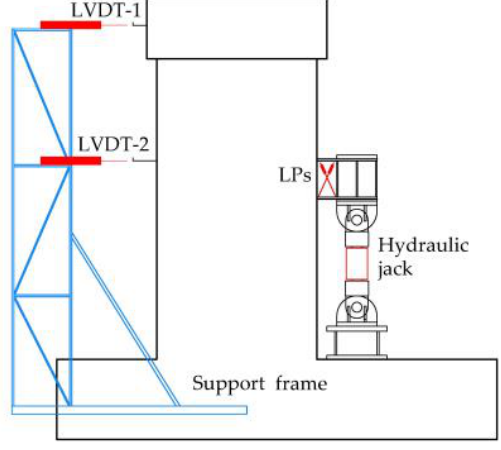
Figure 10. Layout of LVDTs and LPs.